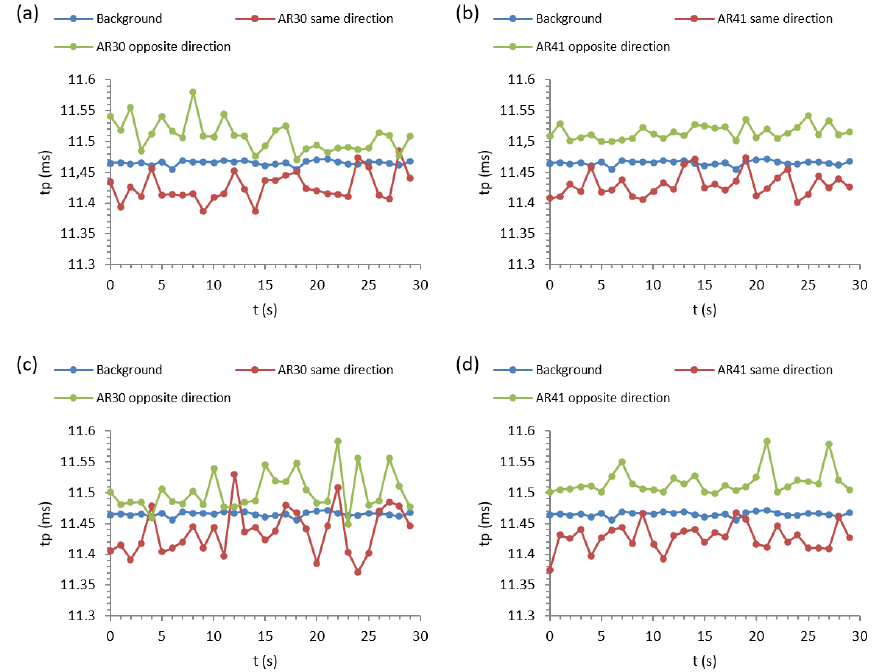
Figure 7. Graphs of the ultrasonic wave propagation time (AR41), with the direction of propagation opposite to the direction of airflow: ( a ) coal dust, ( b ) stone dust, ( c ) coal-stone dust, ( d ) limestone dust.